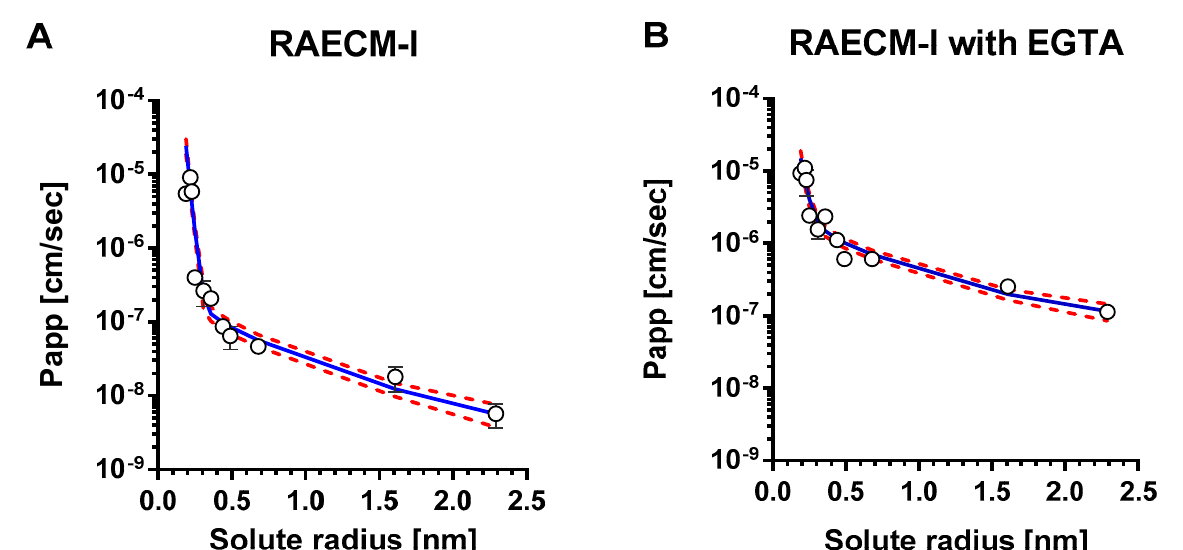
Figure A1. Mean values of P app versus corresponding solute radius across RAECM-I in the absence ( A ) and presence ( B ) of EGTA were analyzed using a maximum likelihood optimization approach, yielding small and large pore characteristics shown in Table A3. Circles represent mean P app and solid curve in blue denotes the heteropore characteristics that best fit the observed mean P app versus corresponding solute radius data. Standard deviation for each mean P app is also shown. Red dotted curves represent solid blue curve ± standard errors.